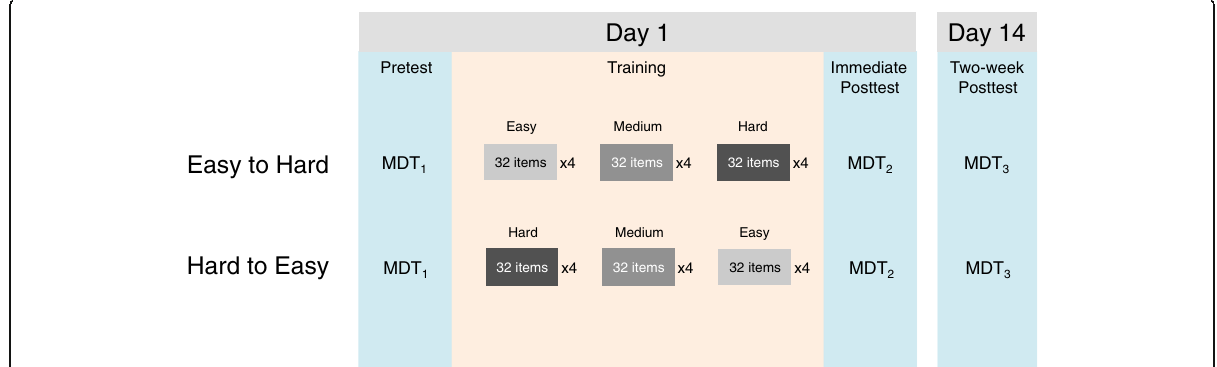
Fig. 4 An illustration of the training and testing schedule used in Experiment 2. Blue boxes represent the MDT. Gray boxes represent the block of training items used in each training session. The lighter the color, the easier the